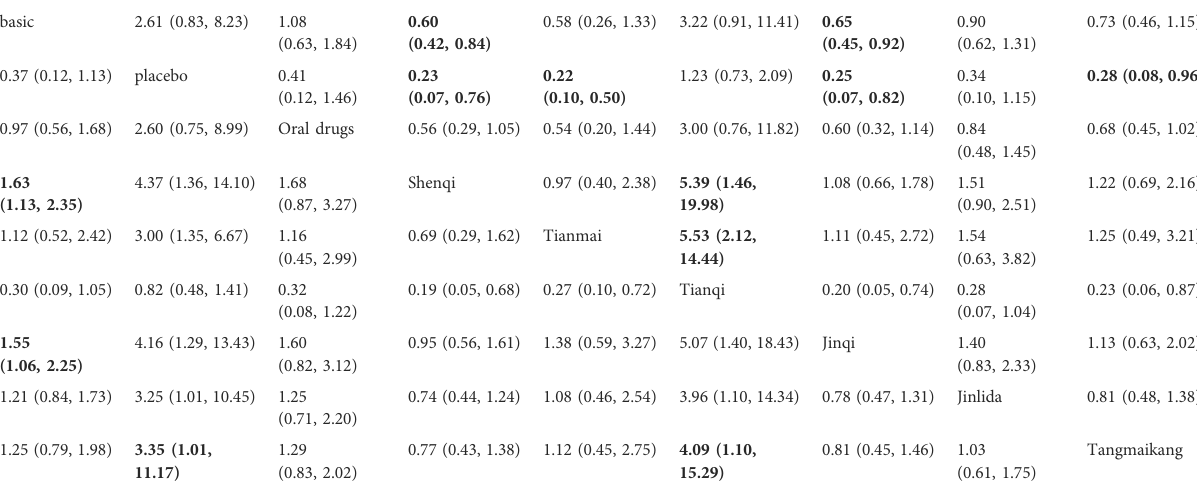
TABLE 4B The league table of Δ TG and Δ TC. Comparisons for Δ TG (bottom left) and Δ TC (upper right) of the 6